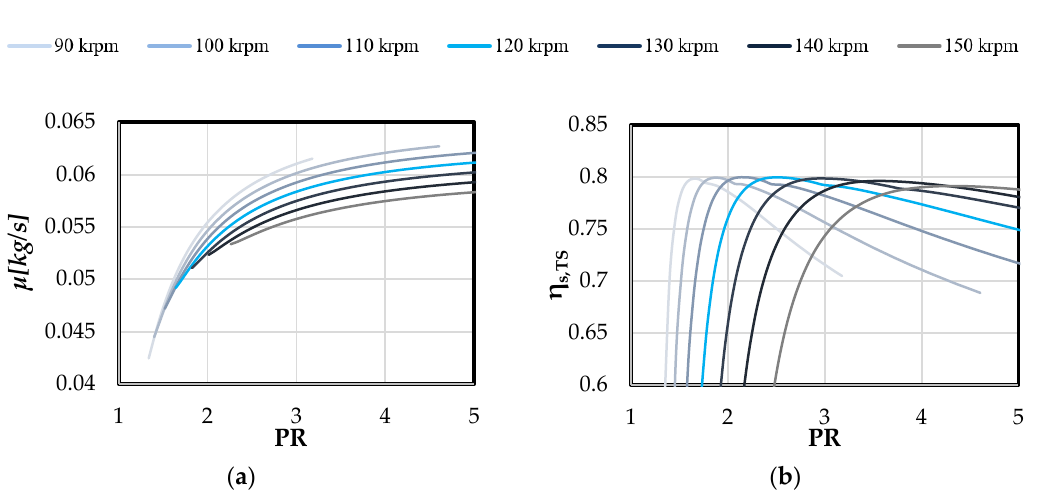
Figure A3. Receiver characteristic maps: variation of outlet temperature ( a ), efficiency ( b ) and pressure drop ( c ) with air corrected mass flow rate.